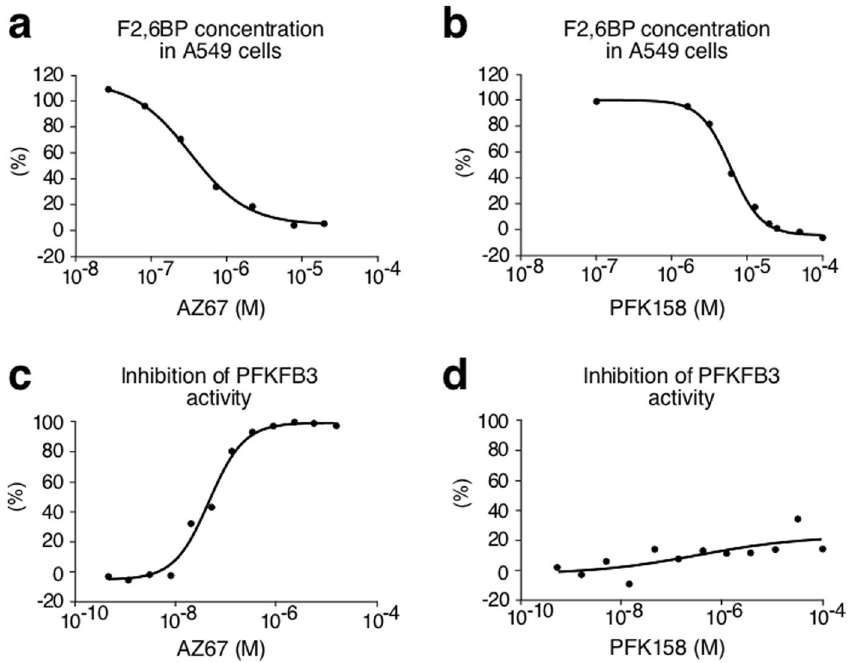
Figure 1. In vitro characterization of two PFKFB3 inhibitors. (a) Incubation of A549 cells with AZ67 (1 h) dose-dependently decreases F2,6BP concentration. (b) Incubation of A549 cells with PFK158 (1 h) dose- dependently decreases F2,6BP concentration. (c) Incubation of human recombinant PFKFB3 with AZ67 dose- dependently inhibits PFKFB3 kinase activity. (d) Incubation of human recombinant PFKFB3 with PFK158 does not inhibit PFKFB3 kinase activity. See also Supplementary Data